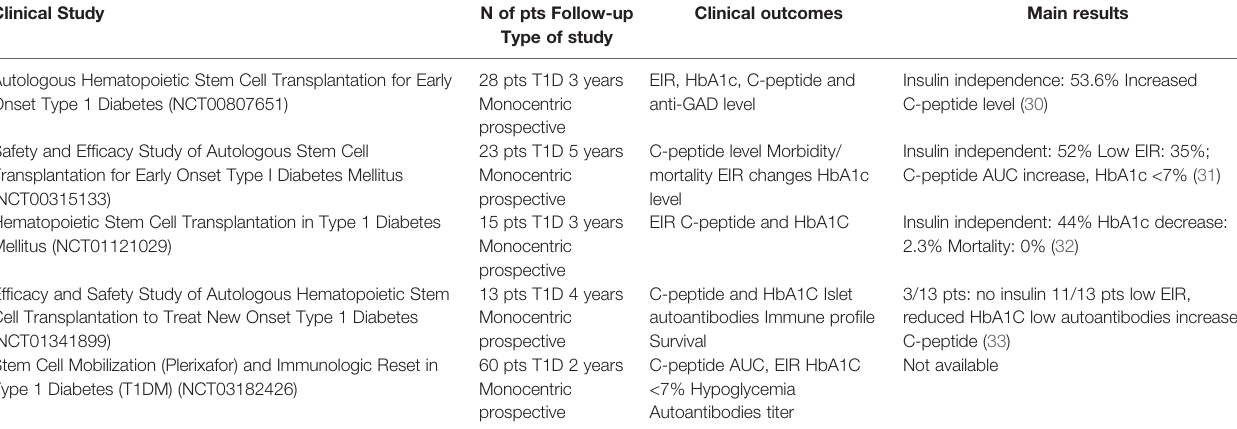
TABLE 1 | Summary of main characteristics, clinical outcomes and results obtained in the clinical studies conducted in T1D and registered in ClinicalTrials.gov. Clinical Study N of pts Follow-up Clinical outcomes Main results Type of study